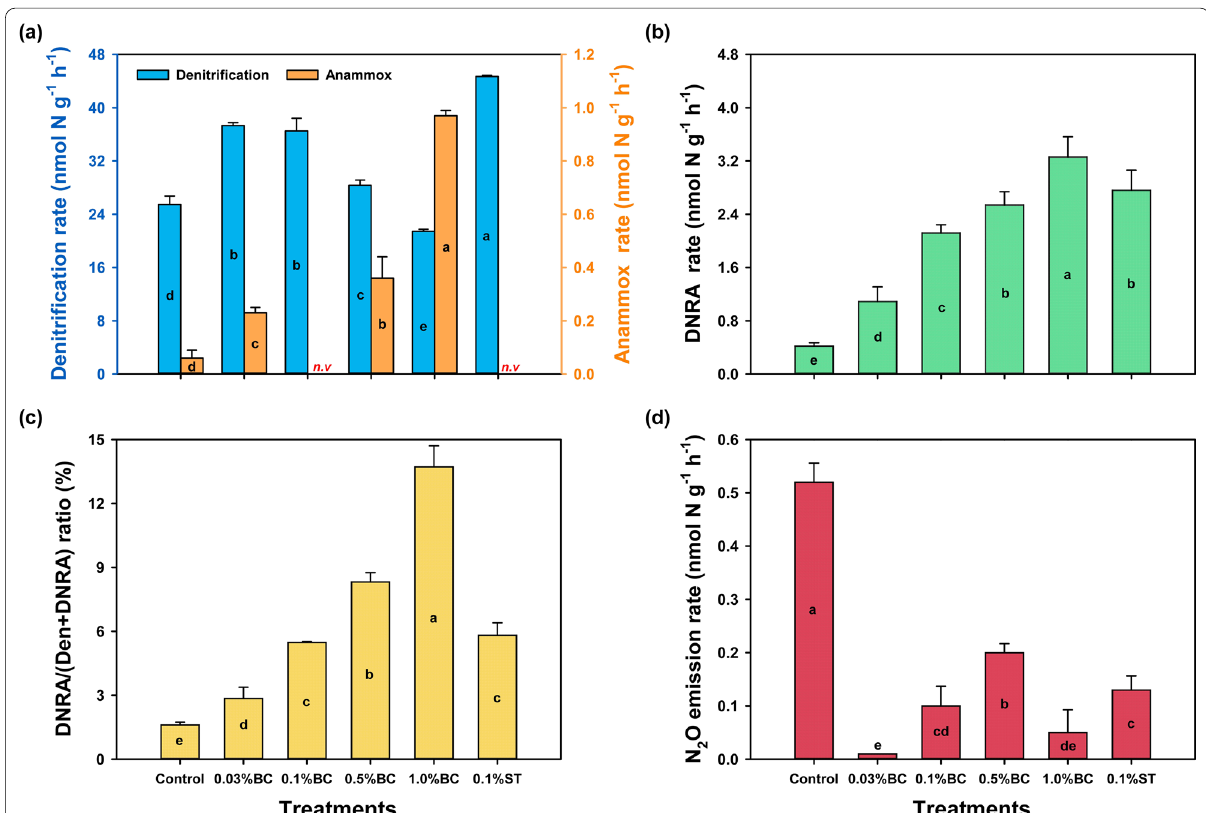
Fig. 1 Denitrification and anammox rates ( a ); DNRA rates ( b ); DNRA/(Den 0.1%BC, 0.5%BC, 1.0%BC, and 0.1%ST treatments. Error bars show the standard deviation of each treatment ( n letter differ significantly among different treatments according to one-way ANOVA ( P < 0.05). “ n.v ” means that the anammox rates in the 0.1%BC and 0.1%ST treatments were negative